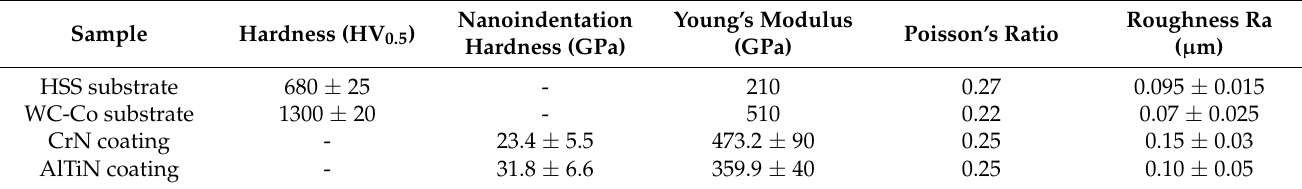
Table 2. Mechanical properties and roughness of substrates and coatings.